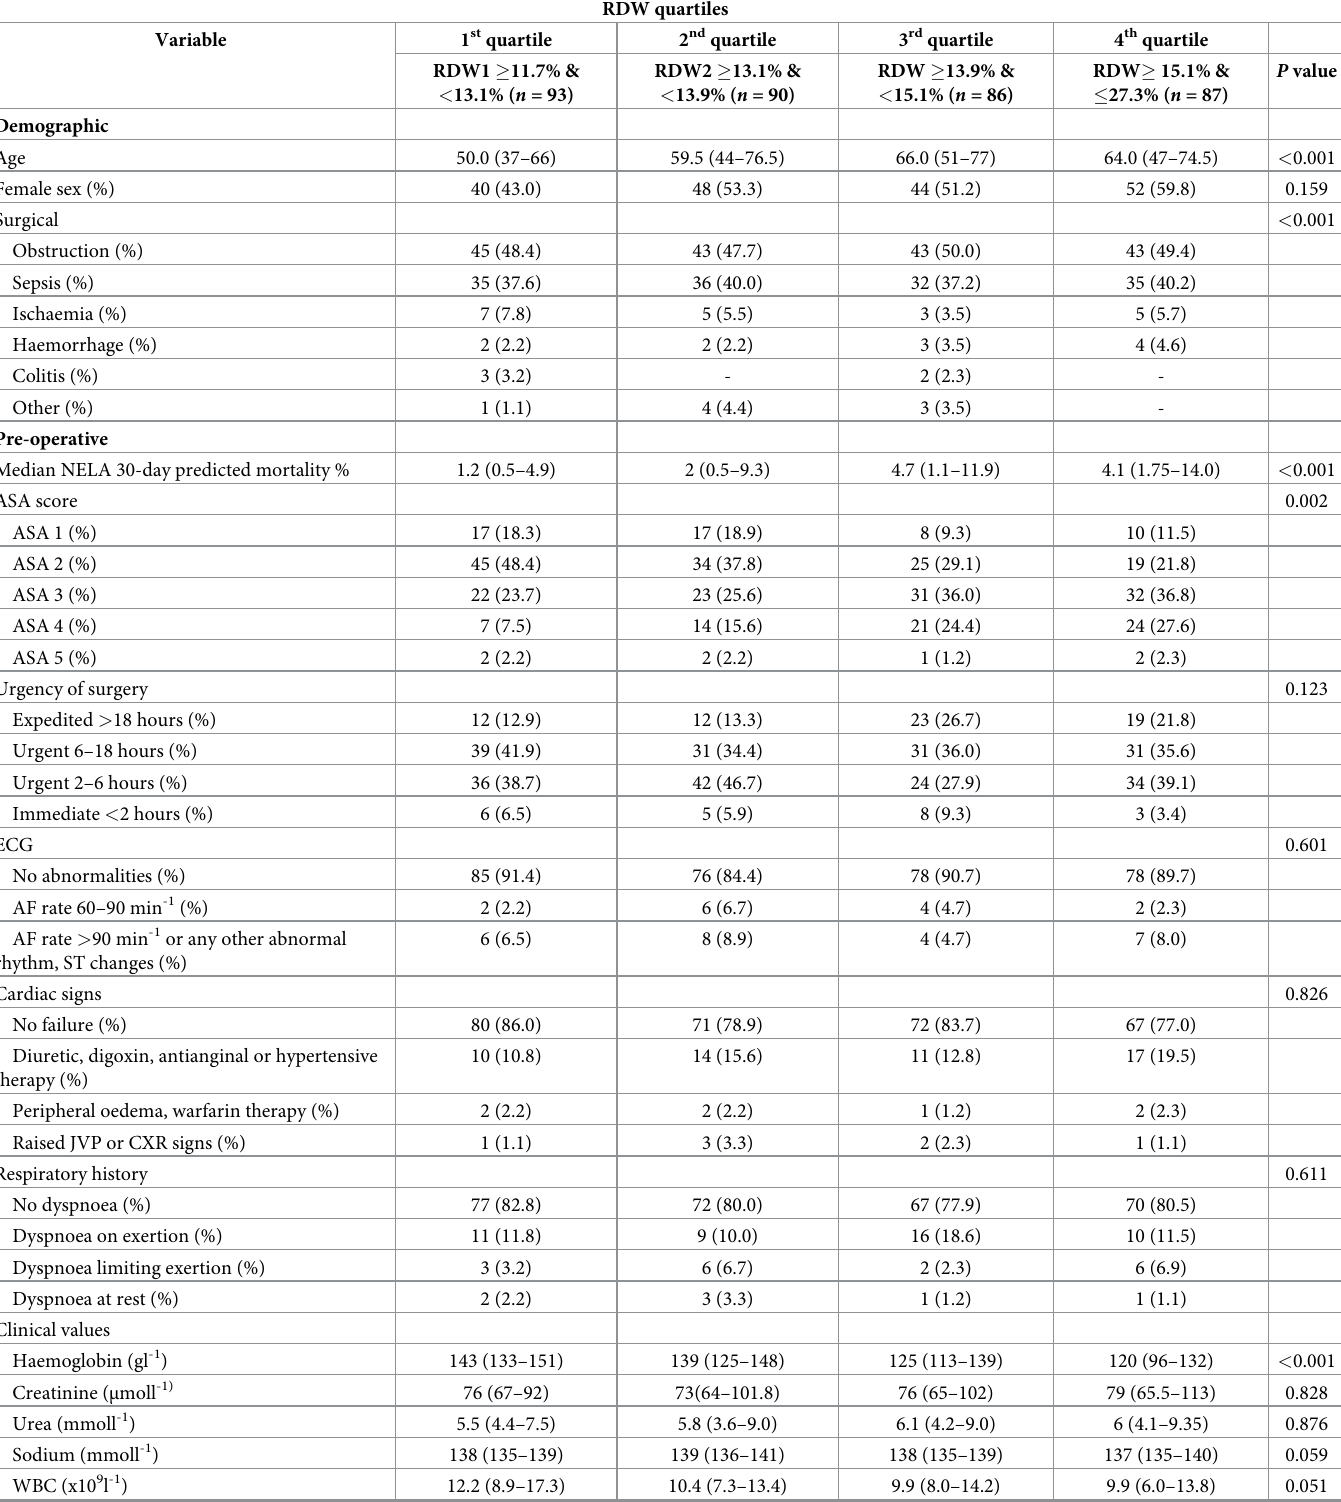
Table 1. Baseline characteristics of patients undergoing emergency laparotomy across red cell distribution width (RDW)